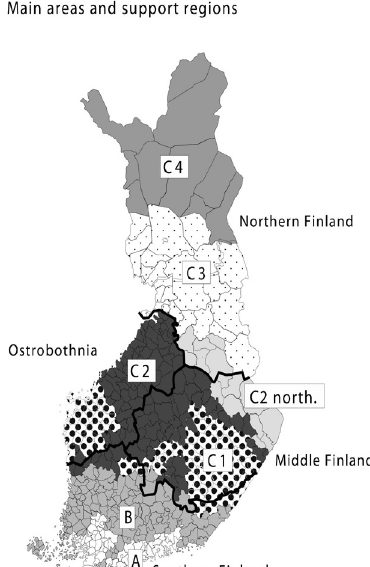
Fig.1. Spatial aggregation of the DREMFIA sector model. The 4 main regions are divided into support-regions (A, B, C1, C2, C2north., C3, C4) based on agricultural policy: Southern Finland —support regions A,B,C1,C2; Middle Finland —support regions B, C1, C2, C2 North; Ostrobothnia —support regions C1 and C2; Northern Finland —C2 North, C3,